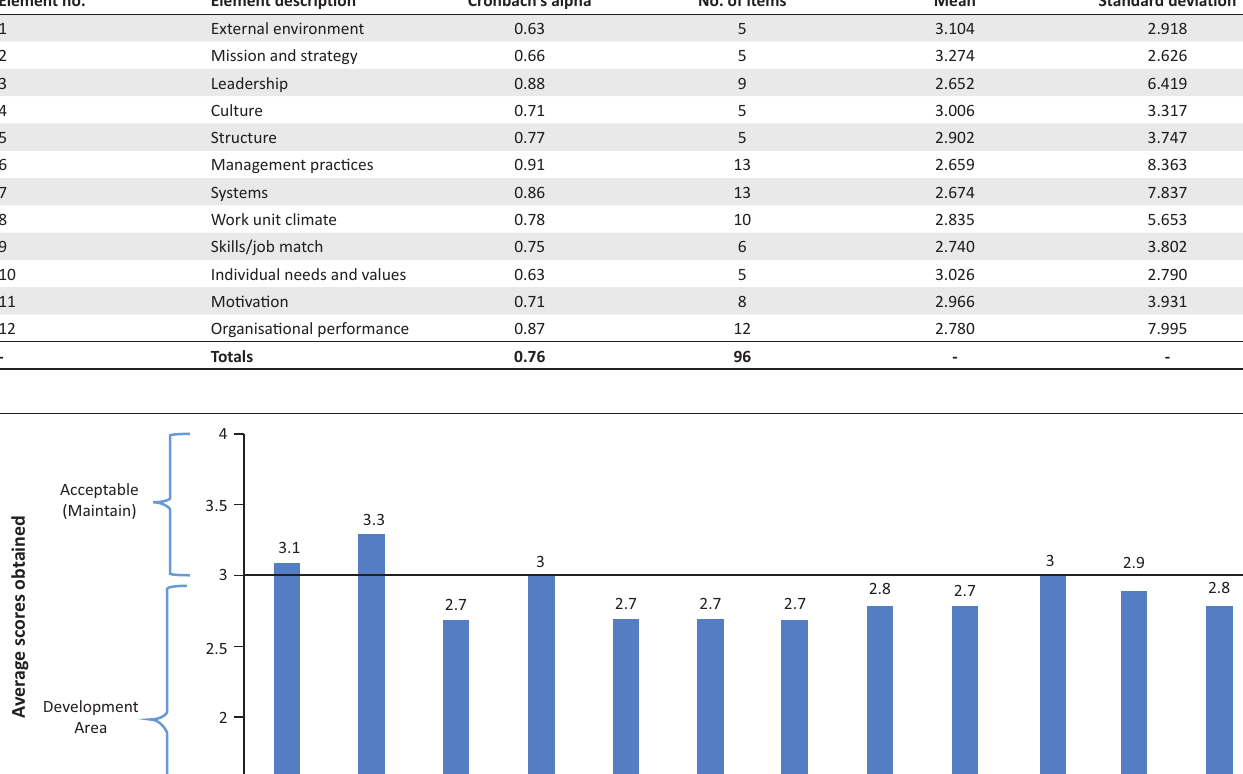
TABLE 2: Reliability statistics for the 12 Burke–Litwin elements measured by the Organisational Performance Questionnaire. Element no.